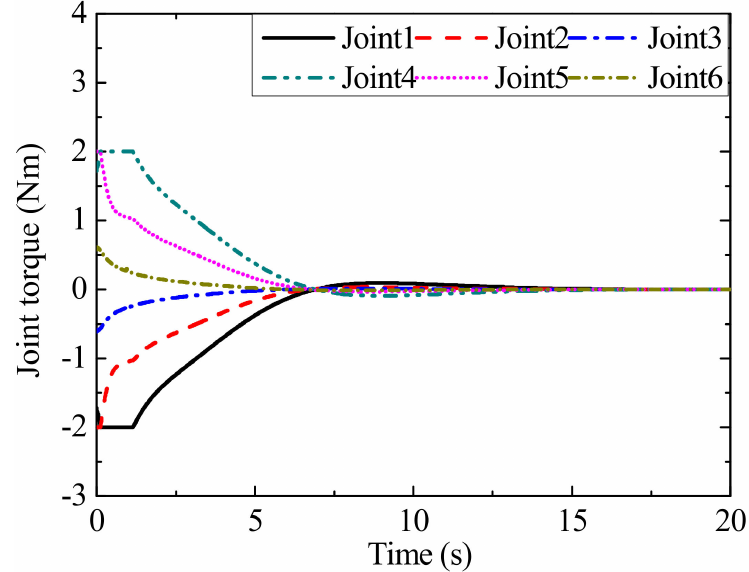
Figure 7. Control inputs in the preassembly